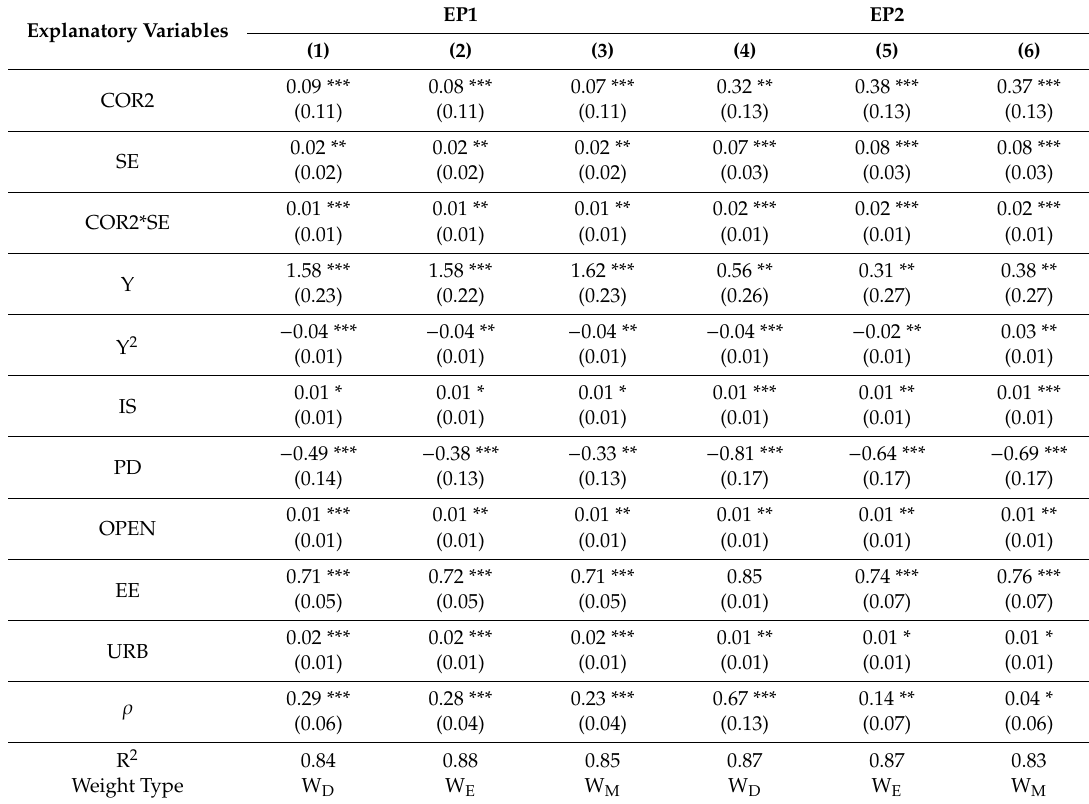
Table 4. Robustness